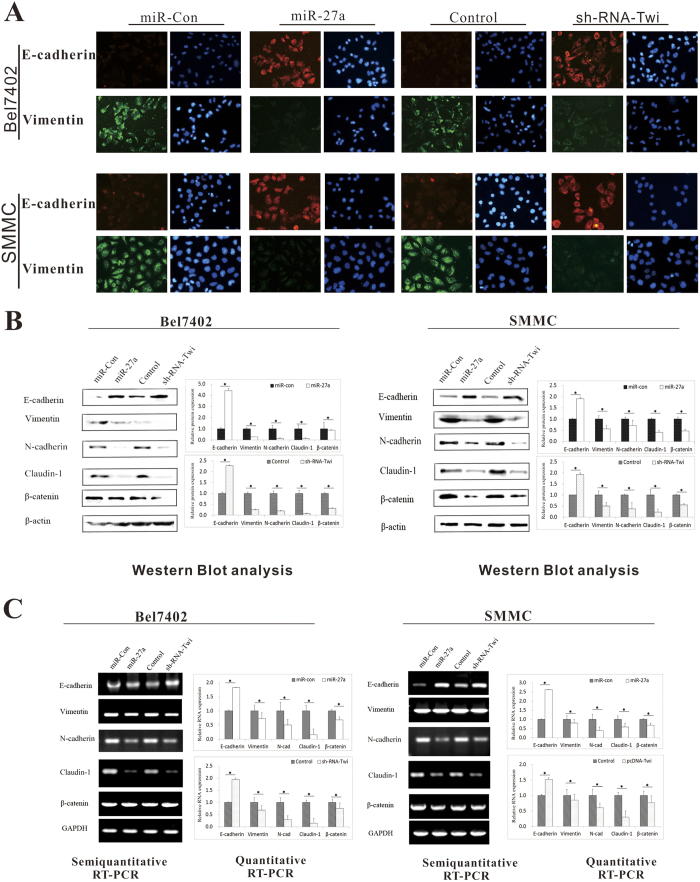
miR-27a-3p suppressed EMT signaling.Bel7402 and SMMC cells were transfected with miExpress™ Precursor miRNA Expression Clone miR-27a-3p (miR-27a) orpGP-Twist-1-shRNA (sh-RNA-Twi). (A) The immunofluorescence results showed the expression of E–cadherin and vimentin in Bel7402 and SMMC cells. (B) Western blot showed the protein expression of E–cadherin, vimentin, N-cadherin, Claudin-1 and β-catenin in Bel7402 and SMMC cells. (C) Semiquantitative and quantitative RT-PCR analyses showed the mRNA expression of E–cadherin, vimentin, N-cadherin, Claudin-1 and β-catenin in Bel7402 and SMMC cells. In immunoblotting assay, gels have been run under the same experimental conditions. Then cropped blots were incubated with different primary antibodies for analysis of signaling pathway. Full-length blots are included in the (supplementary information Fig. S6)